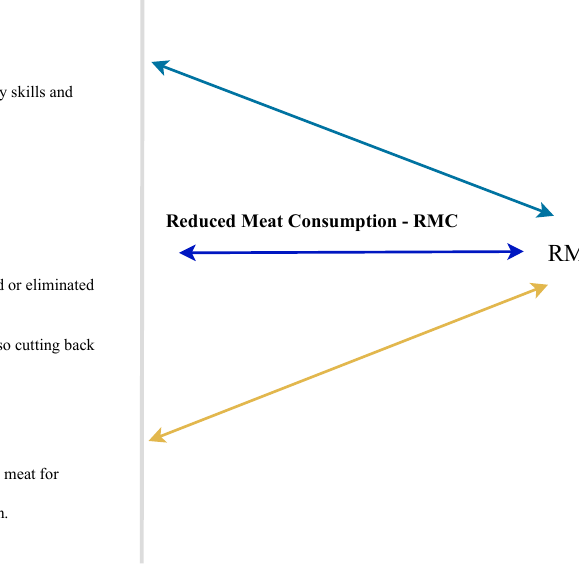
Figure 5. Proposed actions for consumers.